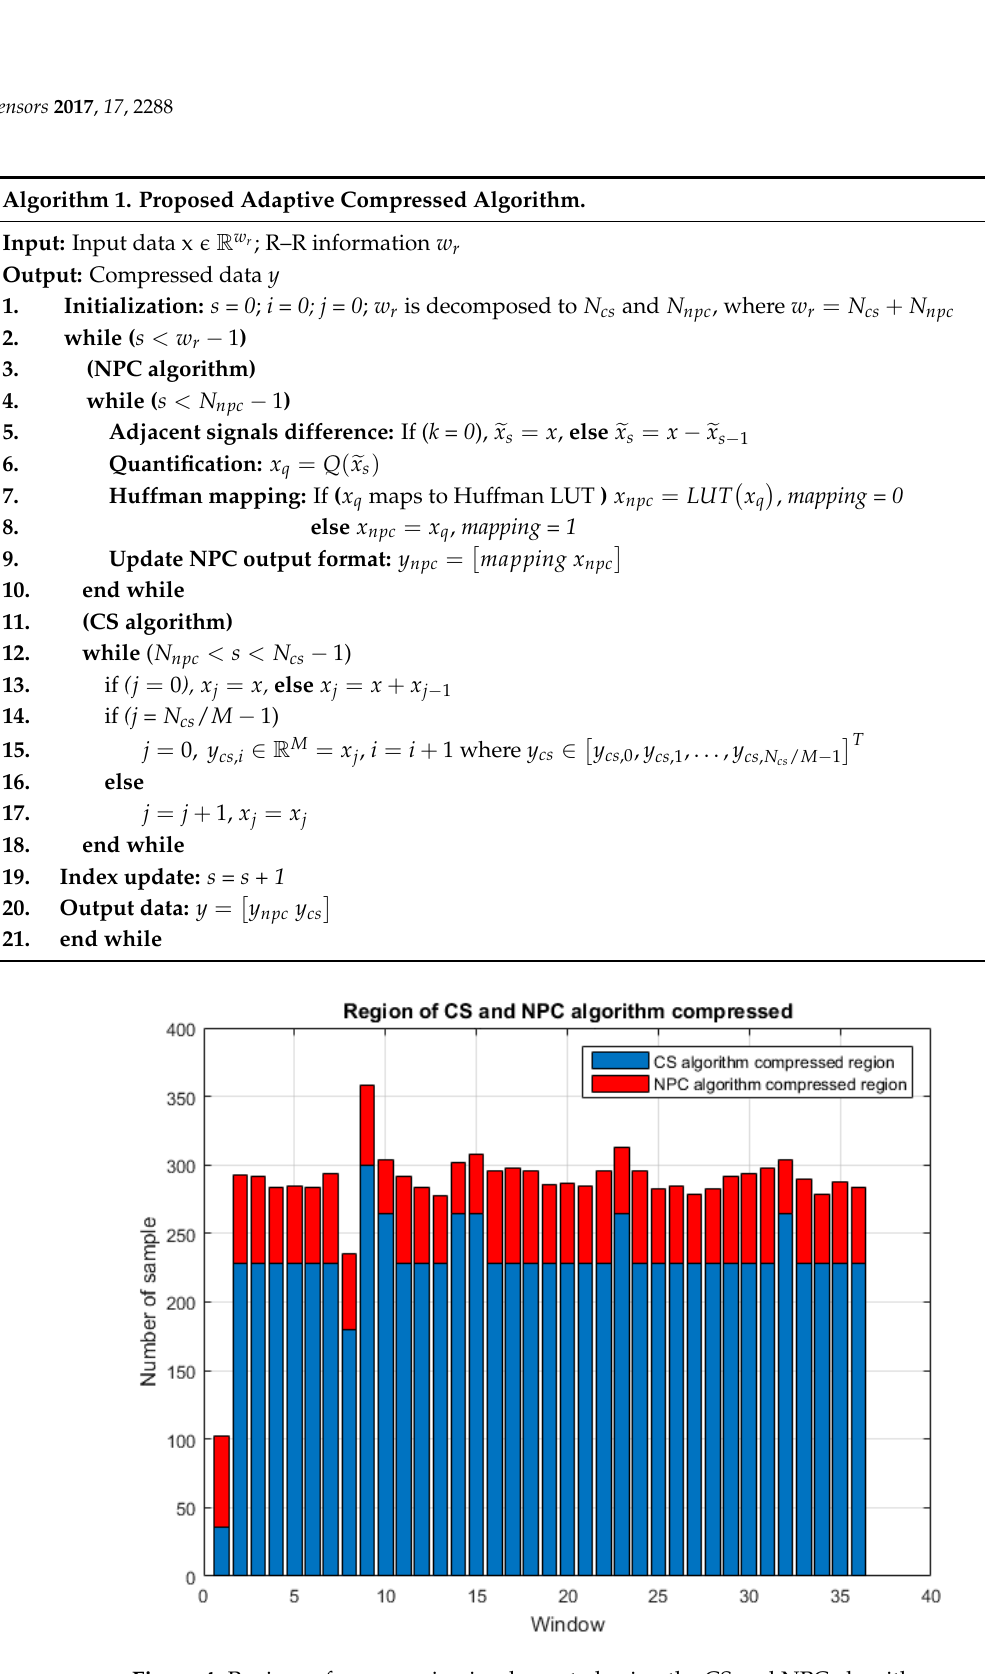
Figure 4. Regions of compression implemented using the CS and NPC algorithms.